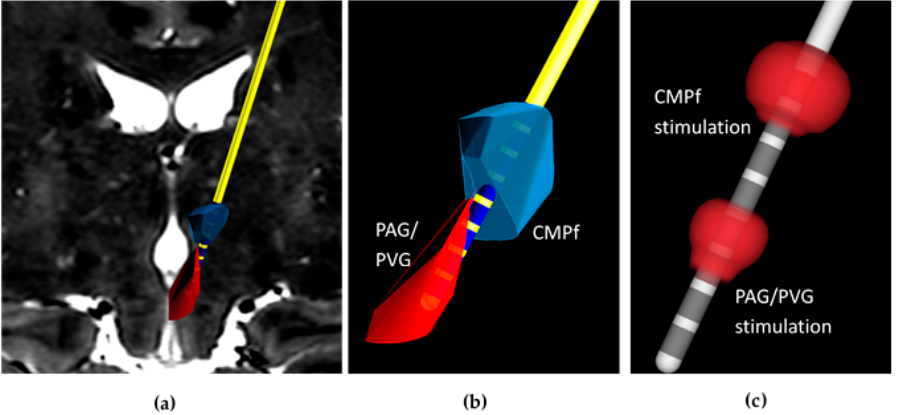
Figure 2. Dual frequency stimulation using a single electrode technique to target the Periaqueductal Grey/Periventricular Grey (PAG/PVG) and Centromedian Intralaminar Parafasciular complex (CMPf) in the treatment of chronic pain. ( a ) Tracings of the CMPf ( blue ) and PAG/PVG ( red ) in coronal plane undergo volumetric reconstruction using NeuroInspire TM software to create 3-dimensional structures for robot-guided DBS electrode implantation; ( b ) Contacts 1–3 and 5–8 are embedded within the PAG/PVG and CMPf respectively along the same trajectory; ( c ) Spherical electrical fields ( red ) at contacts 4 and 8 stimulate the PAG/PVG and CMPf respectively yielding analgesia in a case of refractory phantom limb pain.